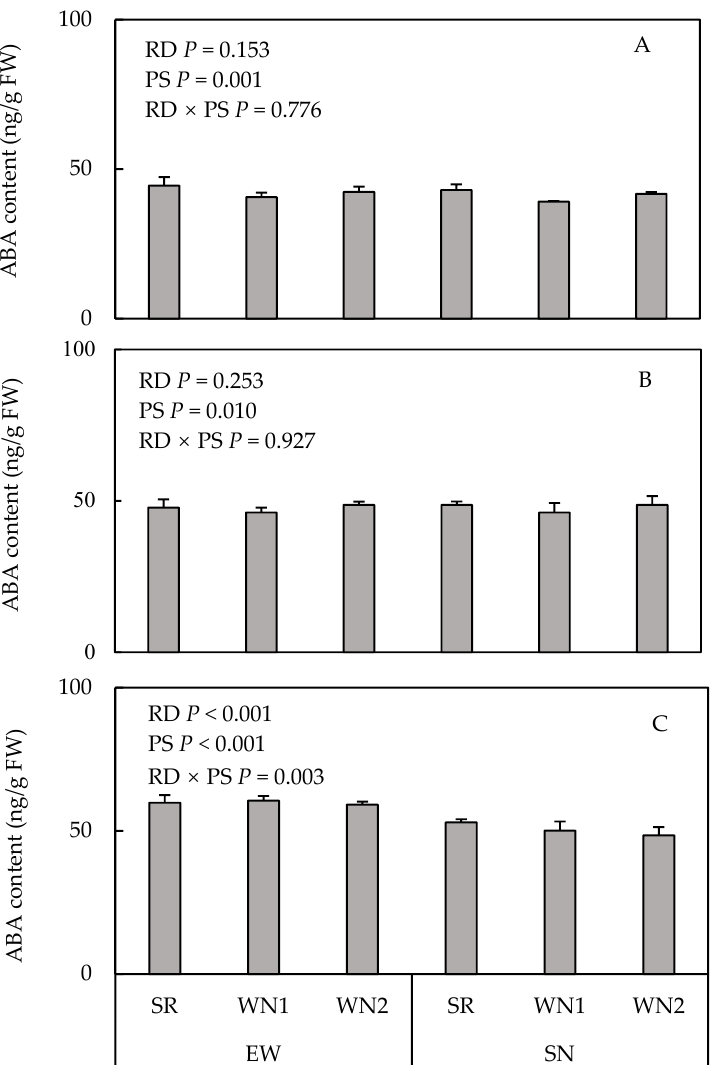
Figure 4. The abscisic acid (ABA) concentration of husk leaf at days after silking (DAS) 12 ( A ), DAS 22 ( B ), and DAS 40 ( C ) of maize under two row directions (RD) and three plant spacings (PS) (EW and SN indicate row direction of east to west and south to north, respectively. SR indicates single rows spaced at 65 cm; WN1 indicates 40 cm twin rows spaced at 90 cm between the paired rows of narrow–wide rows; and WN2 indicates 40 cm twin rows, spaced at 160 cm between the paired rows of narrow–wide rows.). Bars denote the SE of the mean ( n = 3).